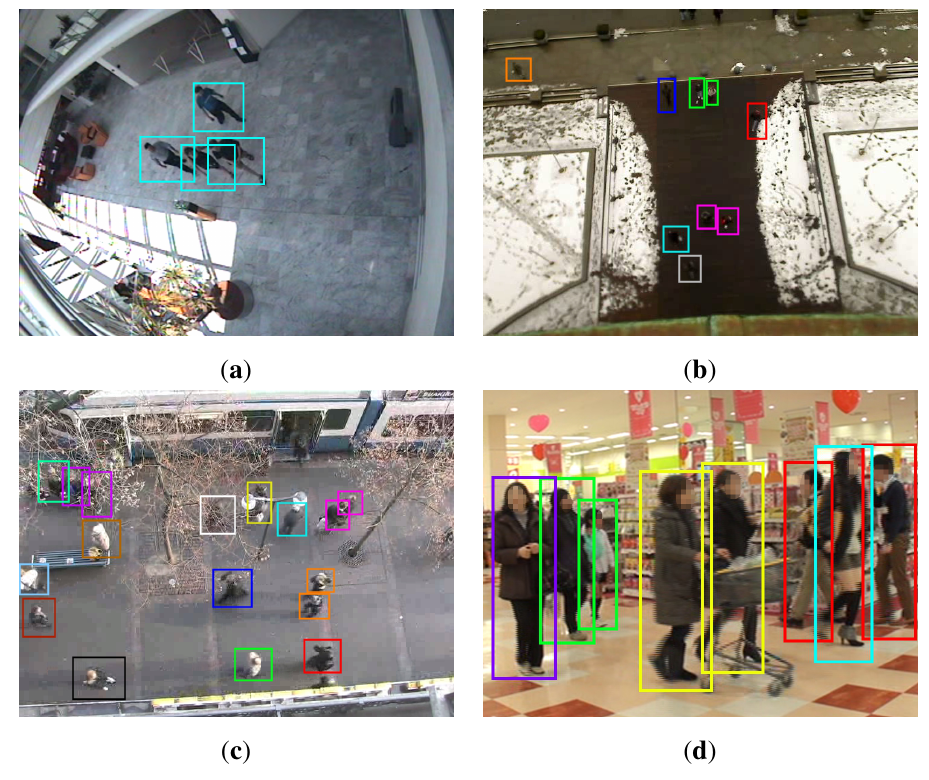
Figure 2. Experiment scenes from datasets ( a ) Caviar; ( b ) BIWI-ETH; ( c ) BIWI-Hotel and ( d ) APT. Pedestrians moving as a group are denoted with bounding boxes of the same color.